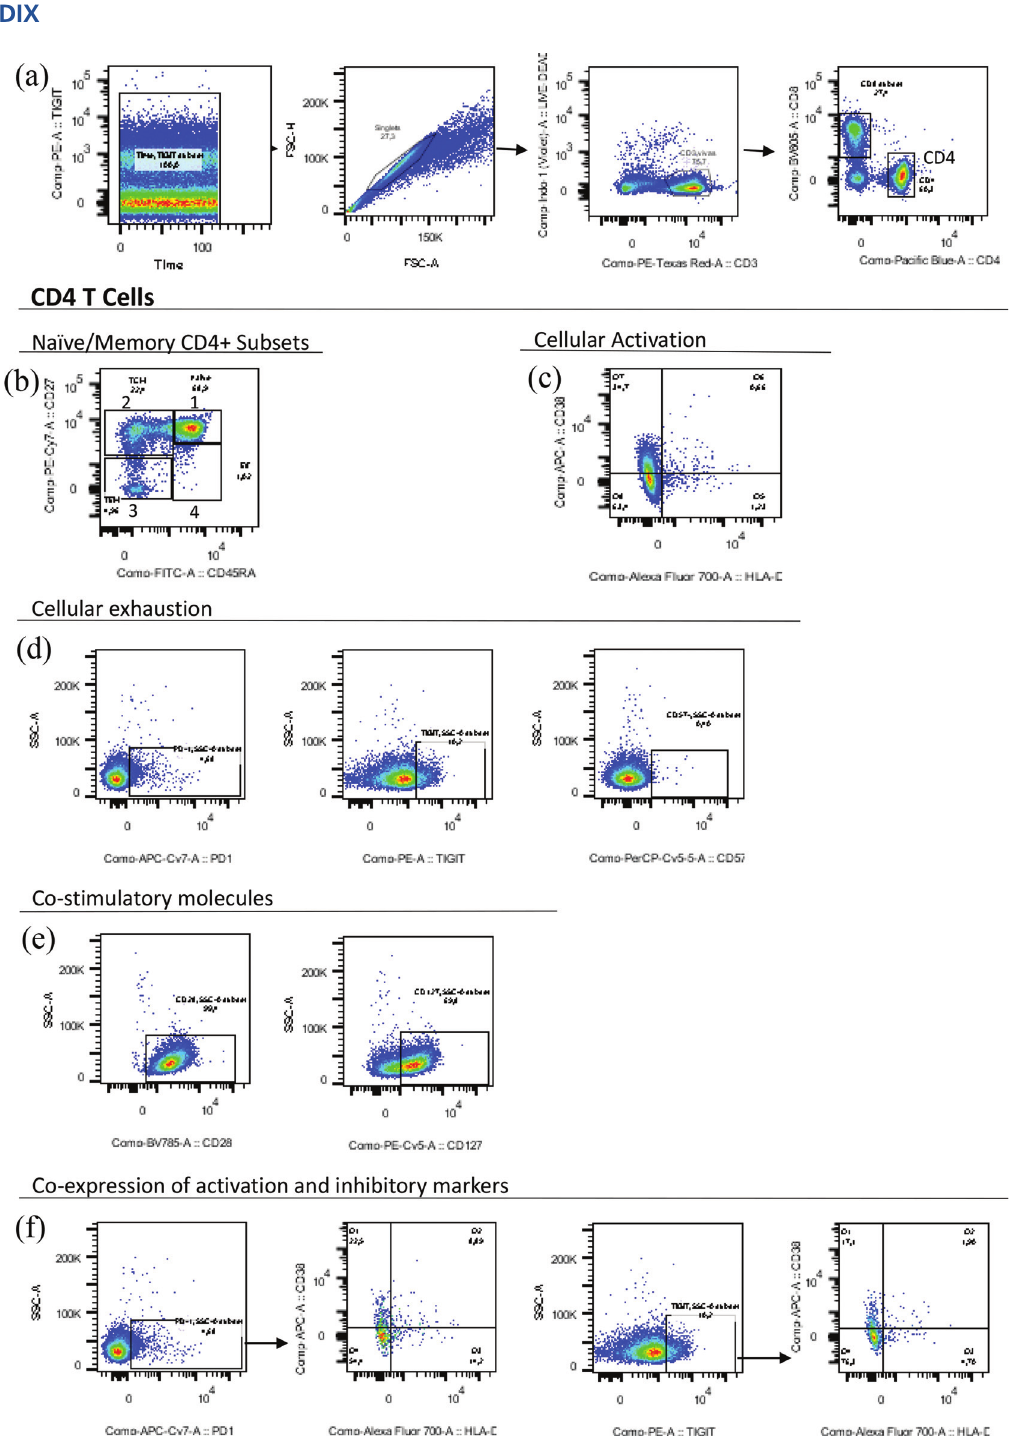
Figure S1 - Strategy for the analysis of flow cytometry data from one representative experiment with peripheral mononuclear blood cell (PBMC) samples of responders and non-responders to the MenC vaccine were used to check ( a ) high-quality parameters (Time (cid:1) PE to check the laser status; Singlets to exclude the doublets cells); Live/Dead x cluster of differentiation (CD)-3-to select living cells positive for CD3 molecule; and the gate CD8 (cid:1) CD4- to choose CD4 + T Cells); ( b) Naı¨ve/Memory CD4 + Subsets were classified according to the differentiated expression of CD45RA and CD27: 1- Naı¨ve (CD45RA + CD27 + ); 2- Central Memory (CD45RA-CD27 + ); 3-Effector Memory (CD45RA-CD27-); 4- Effector cells (CD45RA + CD27-); (c) Cellular activation was characterized according to the expression levels of CD38 and human leukocyte antigen (HLA)-DR; (d) Cellular exhaustion was characterized according to the expression levels of programmed death 1 (PD-1), T cell immunoglobulin and ITIM domain (TIGIT), and CD57; (e) The co-stimulatory molecules investigated were CD28 and CD127; (f) Co-expression of activation and inhibitory markers was done first for gating TIGITor PD-1 CD4 + Tcells, and then, gating those positive for DR and CD38. The parameters used for memory T cells were the same as those used for the CD4 + T cells (data not shown).